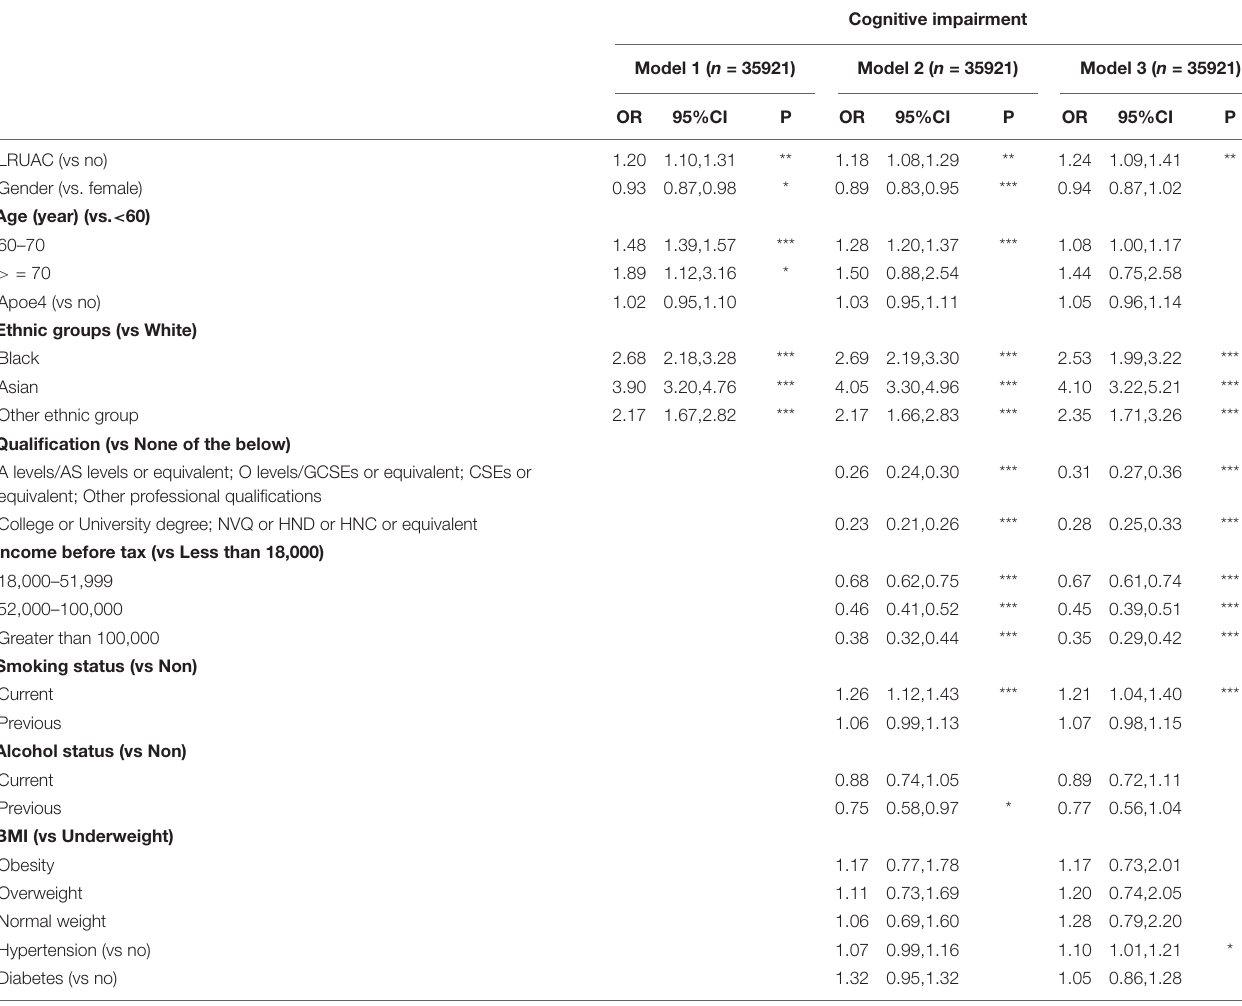
TABLE 2 | Association between long-term/recurrent use of antibiotics and cognitive impairment and fluid intelligence (FI)